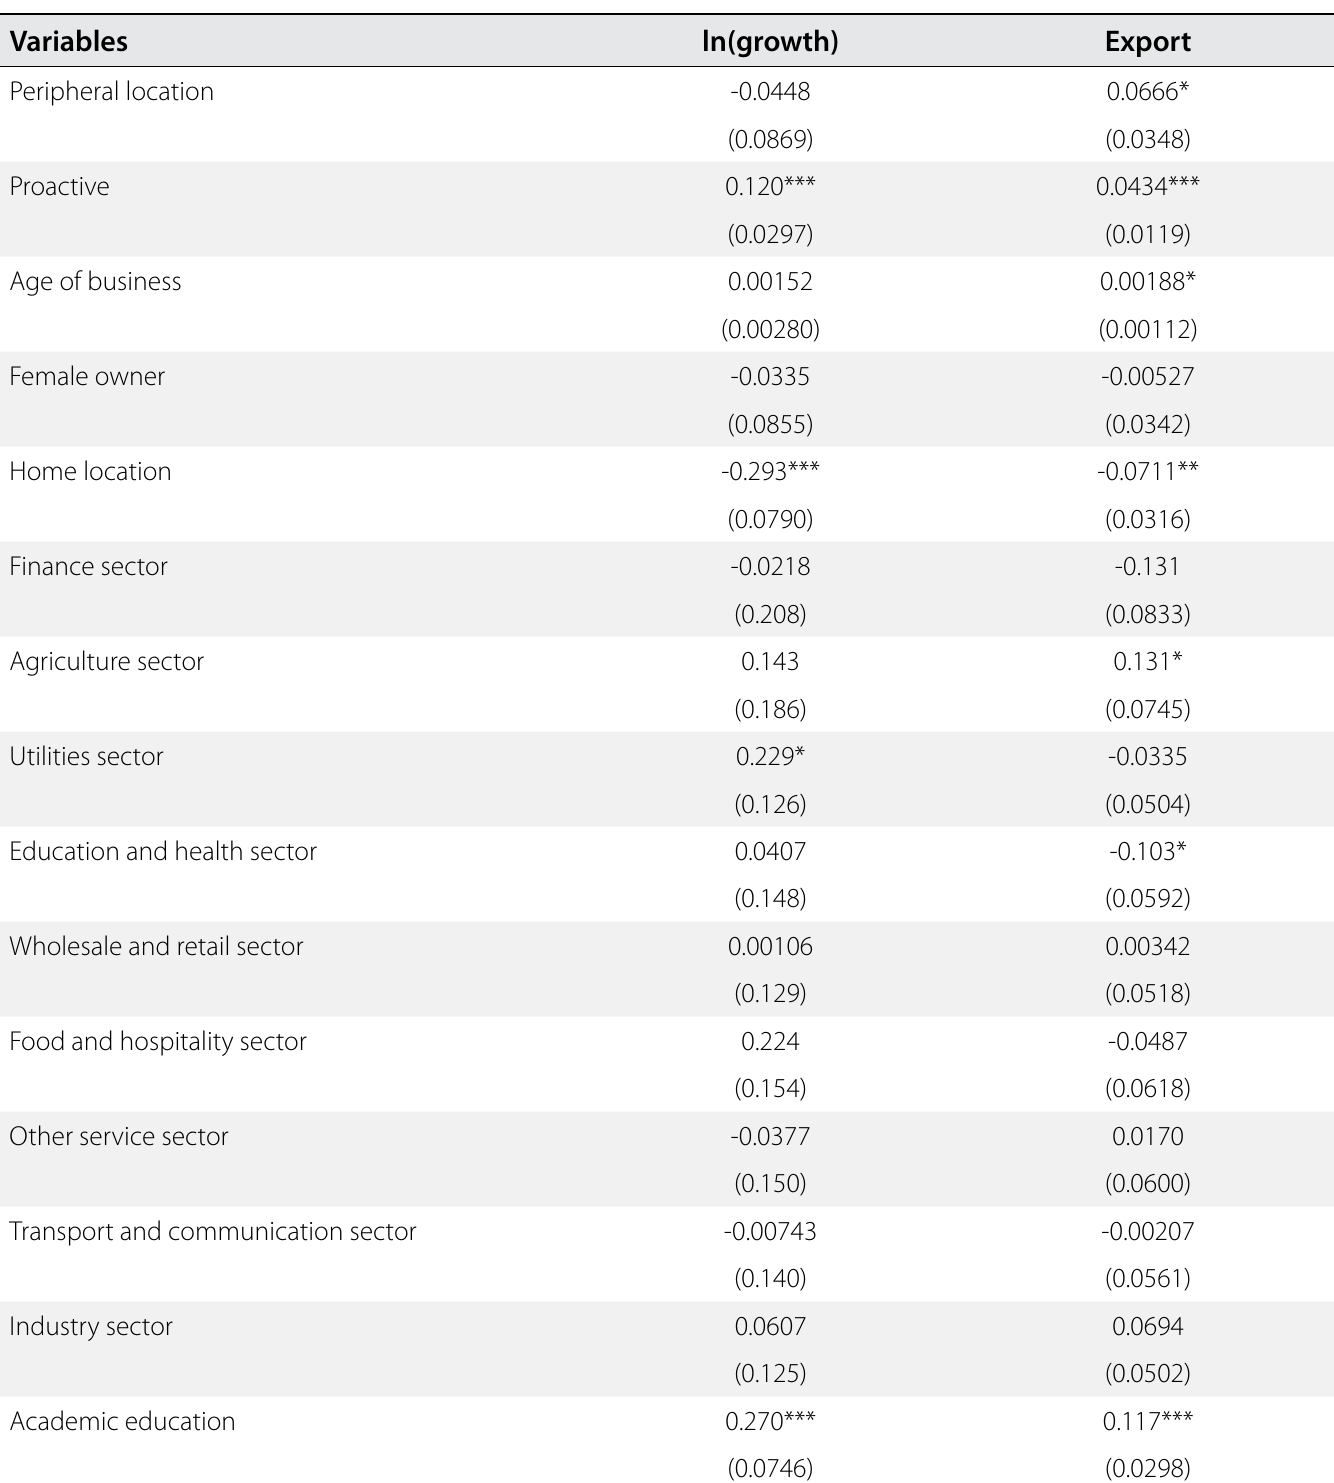
Table 3: Regression